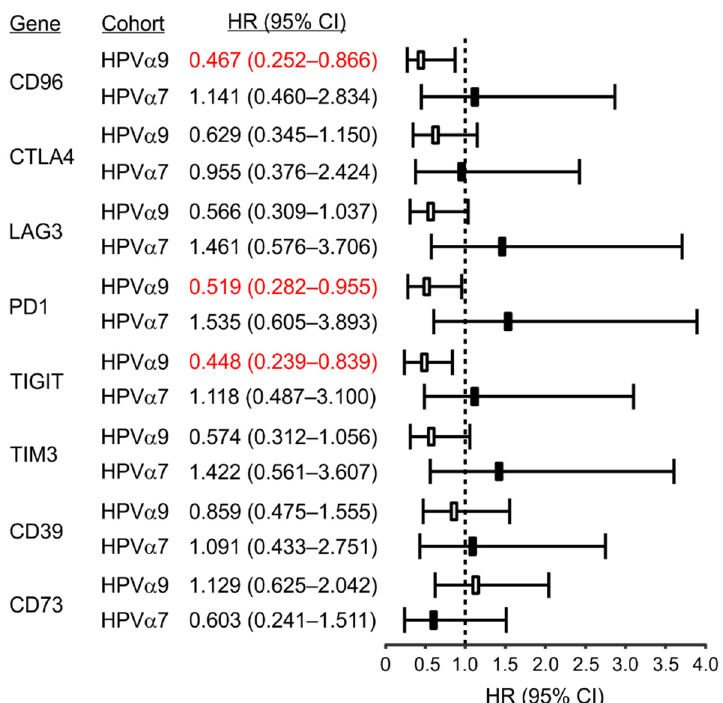
Figure 7. Correlation of immune checkpoint markers with patient mortality in HPV-positive (HPV α 9 and HPV α 7) cervical cancer. Hazard ratios (HR) and 95% confidence intervals (CI) related to immune checkpoint/T-cell exhaustion marker expression for CD96, CTLA4, LAG3, PD1 (PDCD1), TIGIT, TIM3 (HAVCR2), and genes related to immunosuppressive purinergic signals, including CD39 (ENTPD1) and CD73 (NT5E), were calculated. Numbers indicated in red are statistically significant.